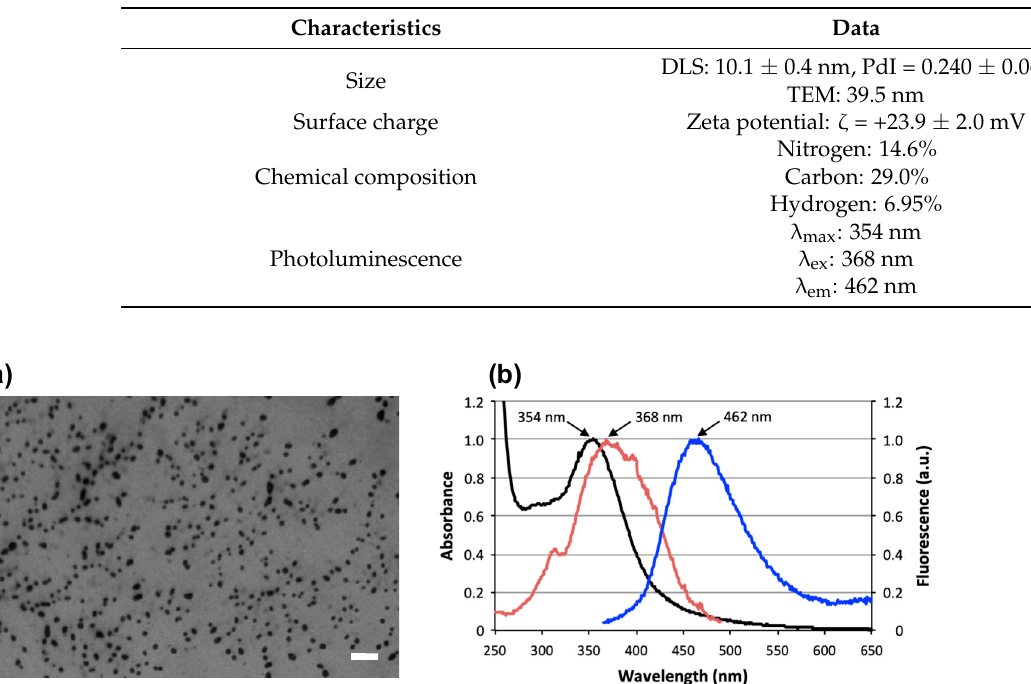
Table 1 . Physicochemical characteristics of CDs.